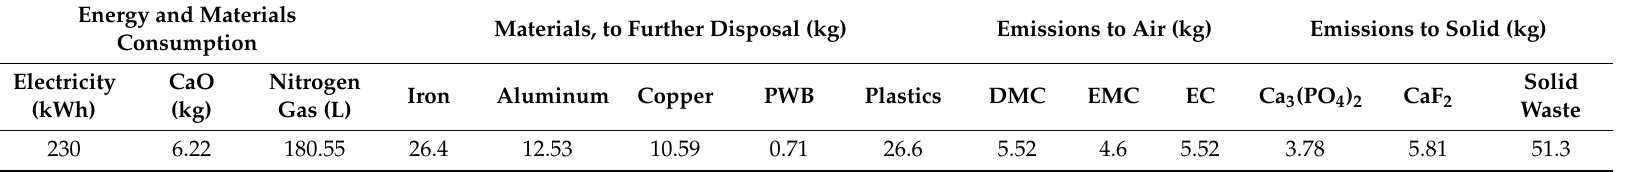
Table 3. The foreground data during the LiFePO 4 (LFP) battery disposal.